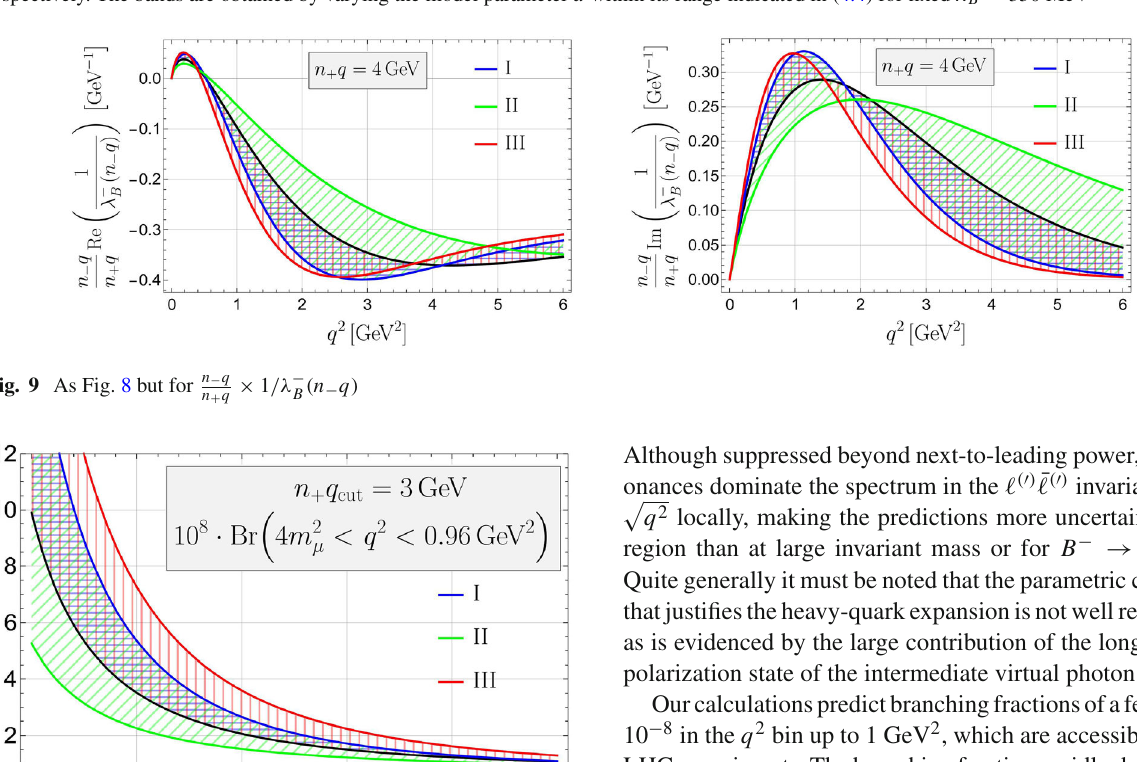
Fig. 8 The q 2 dependence of real (left) and imaginary (right) parts of 1 /λ + respectively. The bands are obtained by varying the model parameter a within its range indicated in (4.4) for fixed λ B = 350 MeV